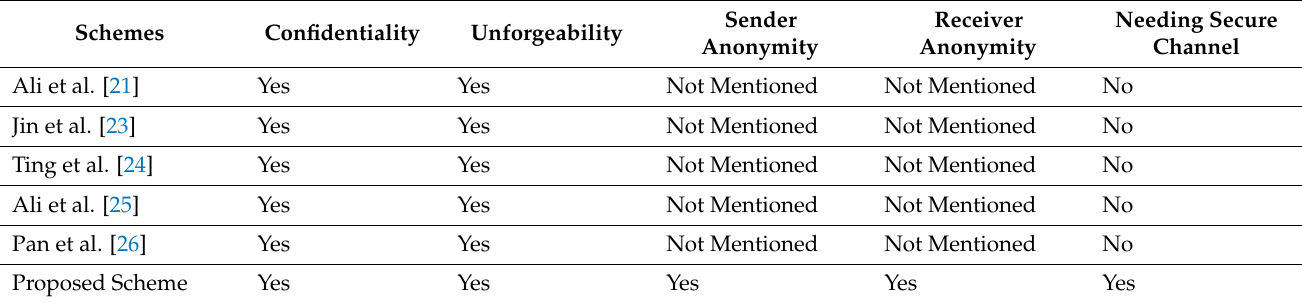
Table 2. Comparison of security properties.